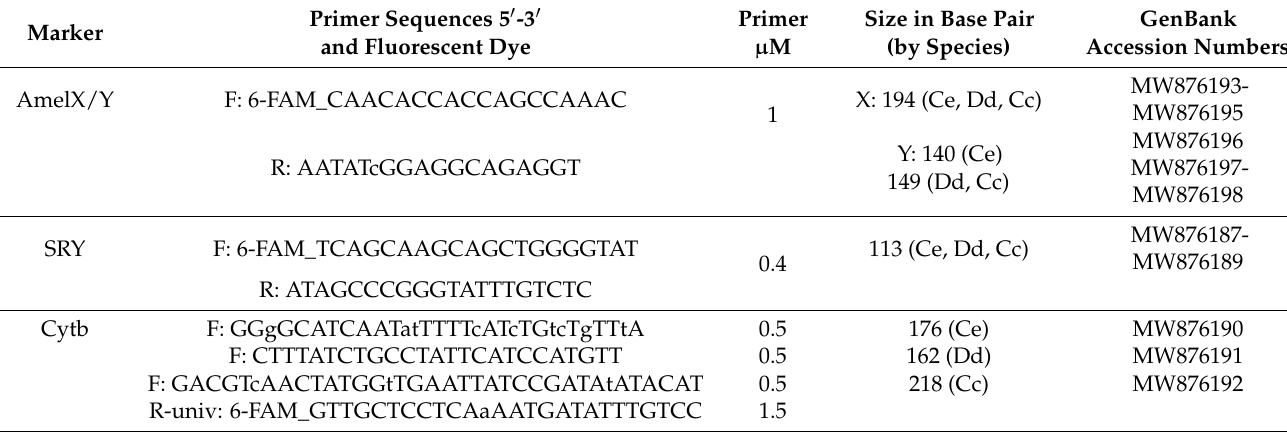
Table 1. Details of the sex chromosome and species-specific markers